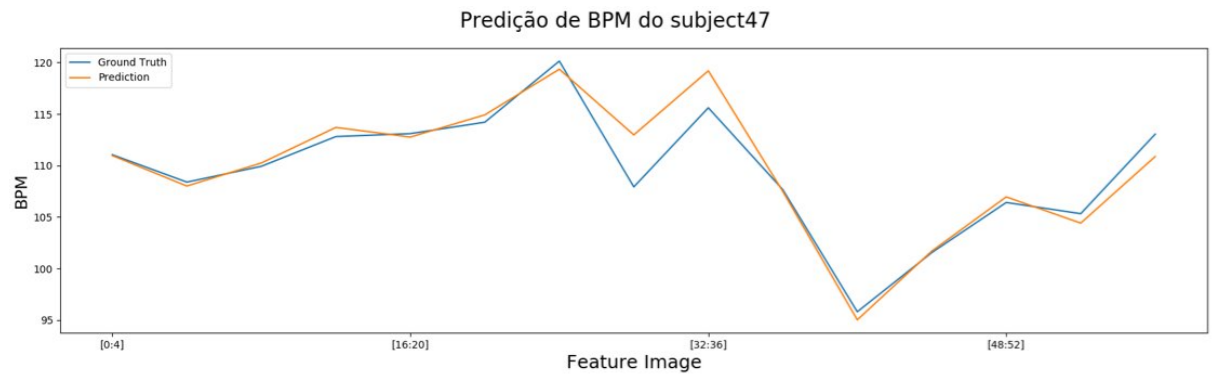
Figure 7. BPM chart with EVM results on subject 47 of the UBFC.